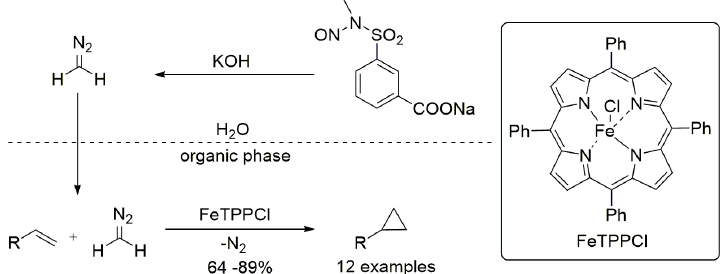
Figure 13 - In situ diazomethane formation and cypropanation in a biphasic system proposed by Morandi and Carreira.